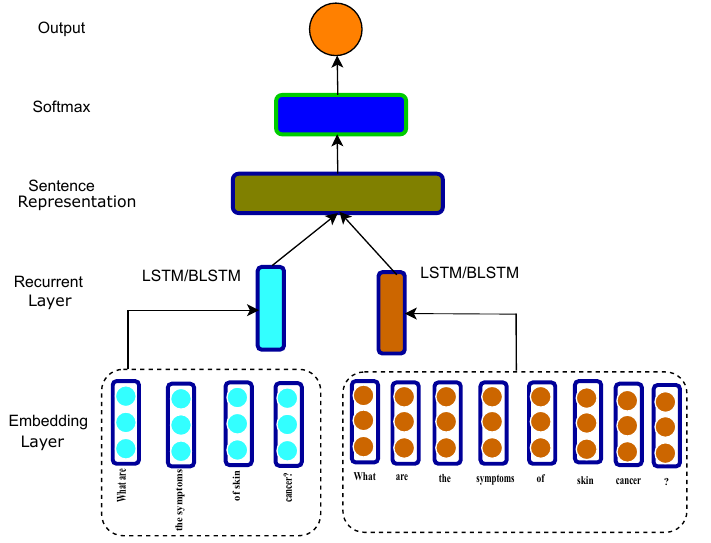
Figure 11. Architecture of Long Short Time